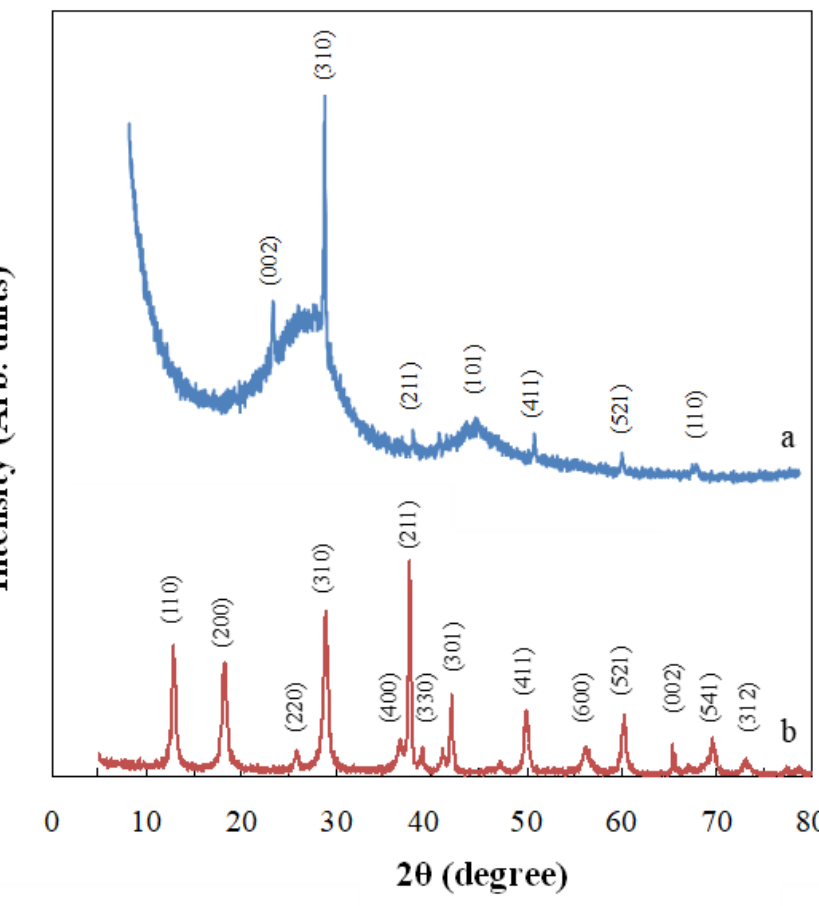
Figure 6. XRD spectra of the MnO 2 /GAC-3 composite ( a ) and synthesised MnO 2 powder ( b